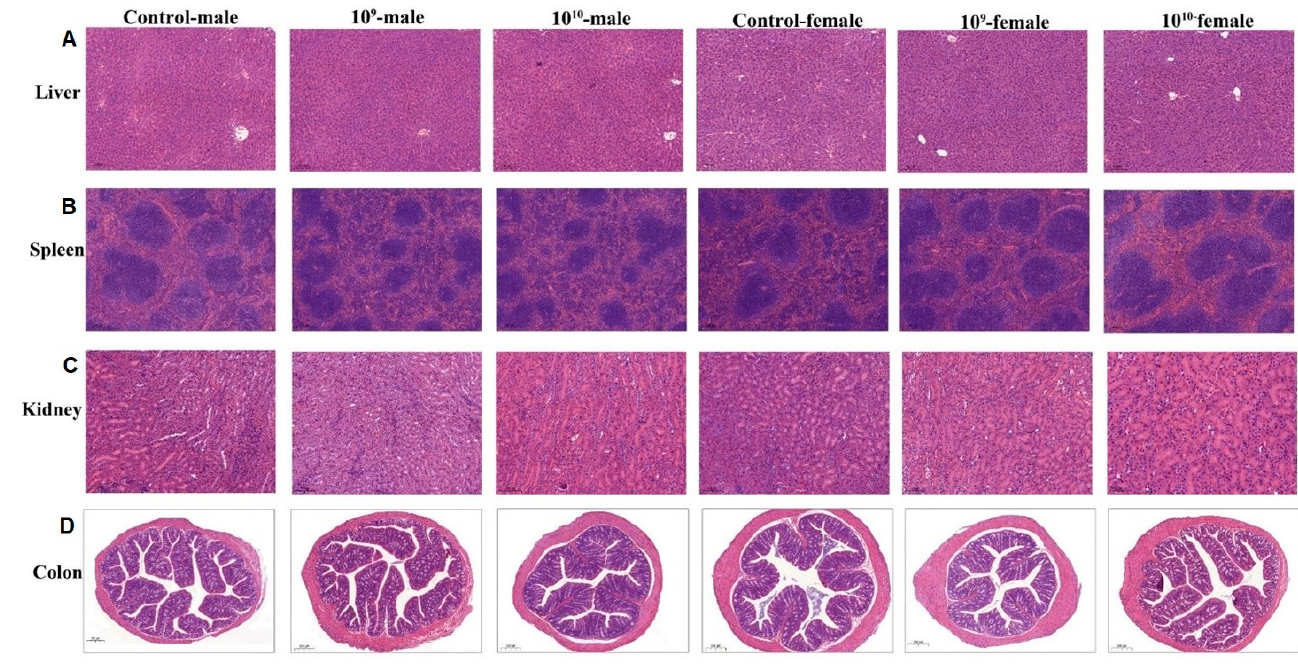
Figure 4. Representative photomicrographs of hematoxylin-and-eosin-stained sections of organ tissues of mice. ( A ) Liver tissue. ( B ) Spleen tissue. ( C ) Kidney tissue. ( D ) Colon tissue.